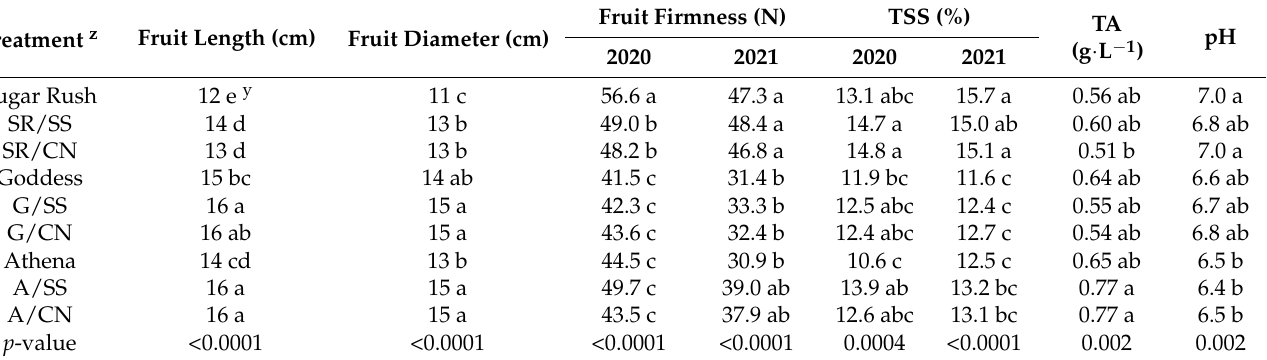
Table 5. Fruit length and diameter, fruit firmness, total soluble solids, titratable acidity, and pH of cantaloupe cultivars Sugar Rush (SR), Goddess (G) and Athena (A) nongrafted and grafted onto two rootstock cultivars Super Shintosa (SS) and Carnivor (CN) at Mount Vernon, WA, USA, in 2020 and 2021 (years combined when there was no treatment by year